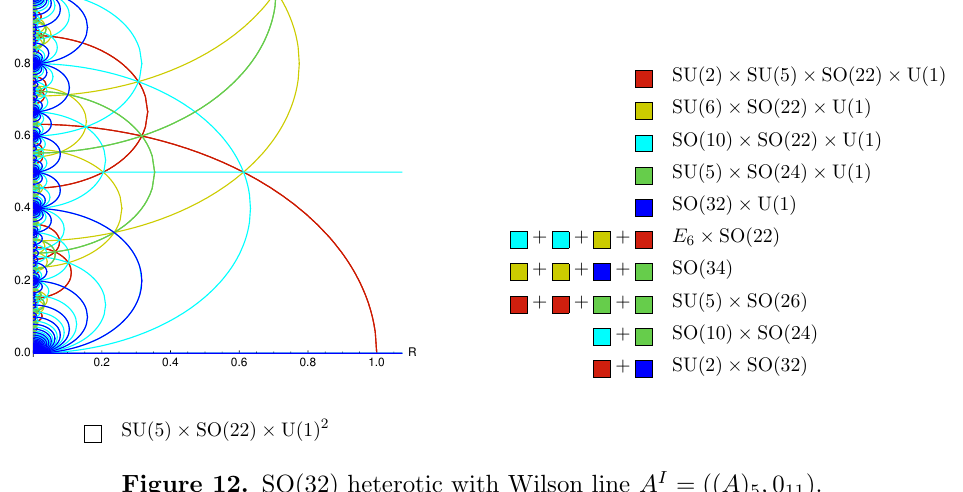
Figure 12. SO(32) heterotic with Wilson line A I = (( A ) 5 ; 0 11 ).